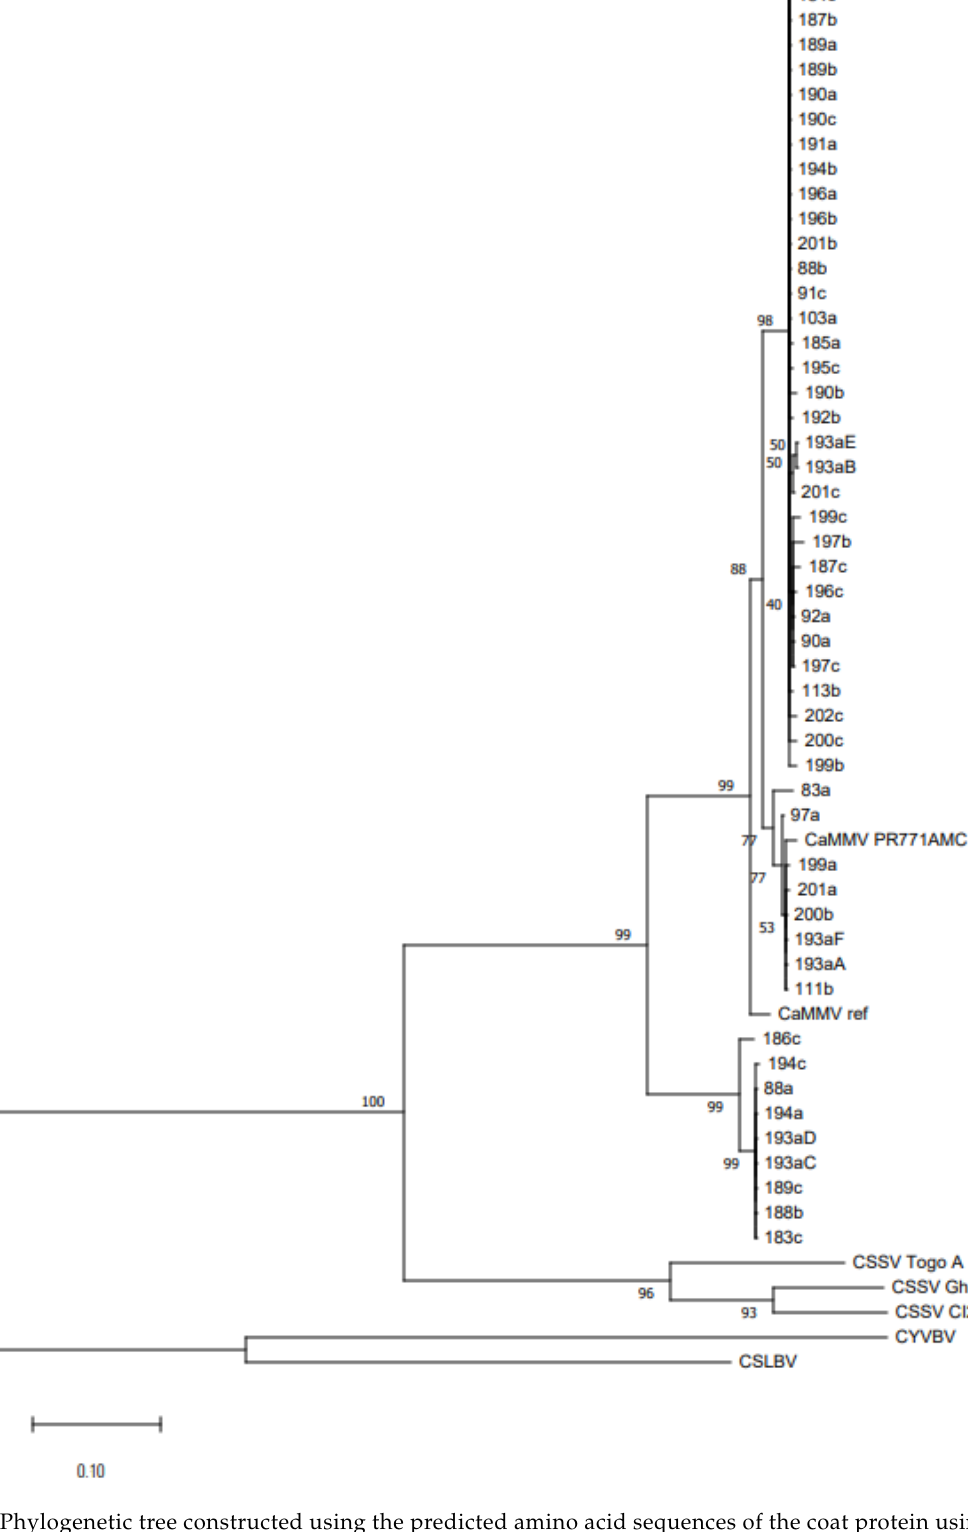
Figure 4. Phylogenetic tree constructed using the predicted amino acid sequences of the coat protein using maximum- likelihood method and neighbor-joining algorithm provided in MEGAx. Sequences of cacao-infecting badnaviruses